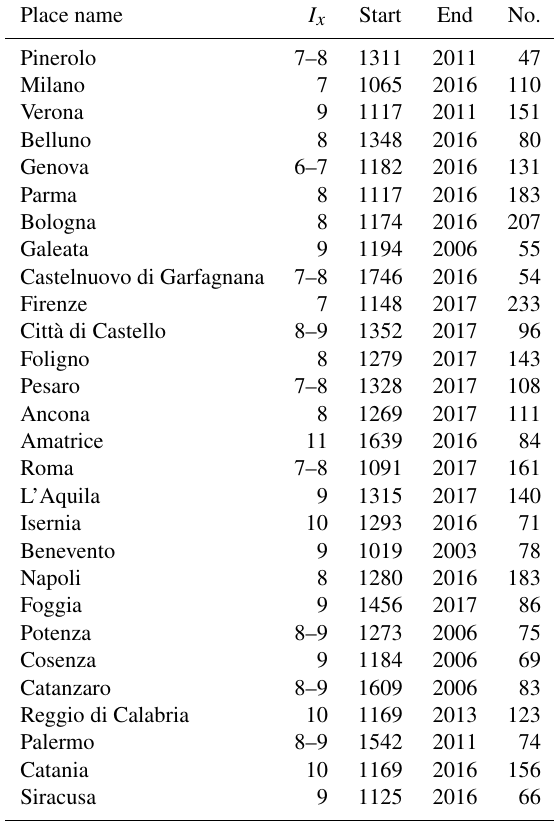
Table 2. List of the 28 test localities with their maximum intensity ( I x ), time coverage of seismic histories in terms of starting (Start) and ending (End) years, and number of intensity data (No.) as re- ported in